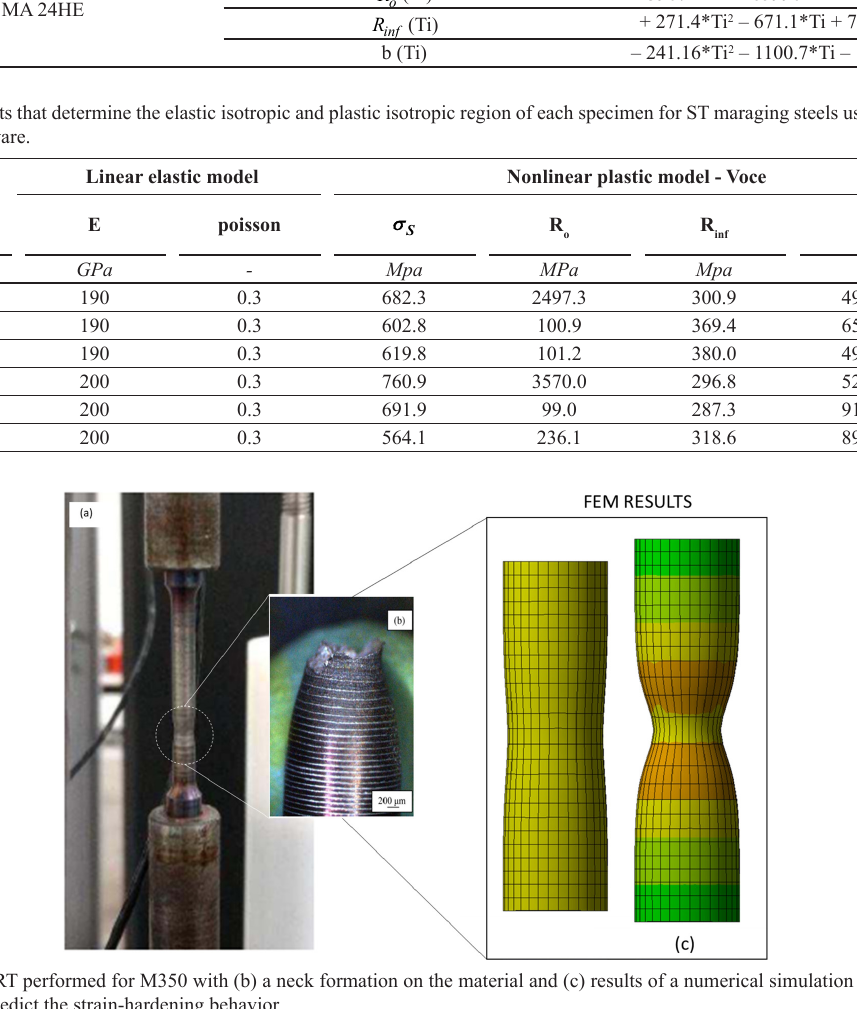
Figure 9. (a) SSRT performed for M350 with (b) a neck formation on the material and (c) results of a numerical simulation using Voce parameters for predict the strain-hardening behavior.